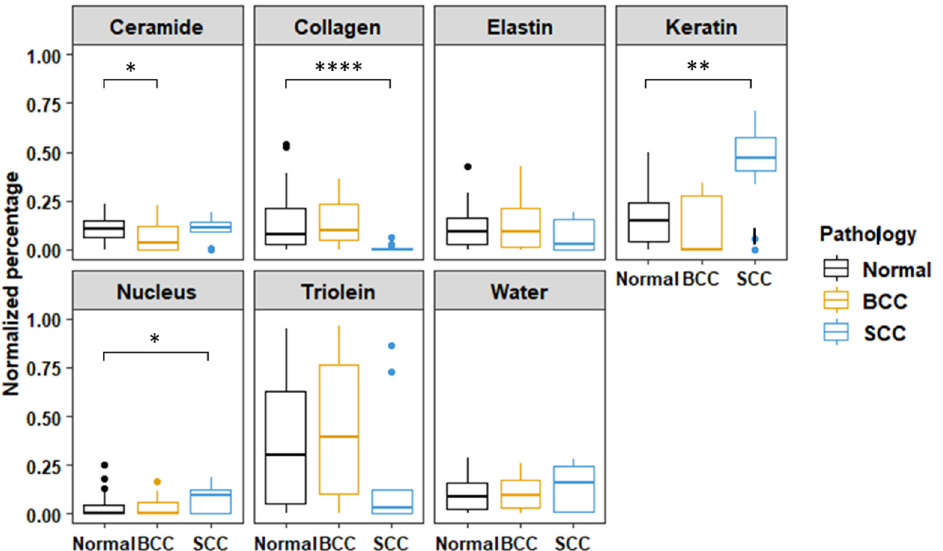
Figure 4. Statistical analysis to compare differences in the contribution of biomarkers in the tumor (BCC or SCC) and normal skin (including the dermis, hair follicles, sebaceous glands, and fat) Statistical analysis was performed via analysis of variance (ANOVA) combined with Tukey’s test as a post hoc analysis. Statistical significance notion: * p ≤ 0.05, ** p ≤ 0.01, *** p ≤ 0.001, **** p ≤ 0.0001.